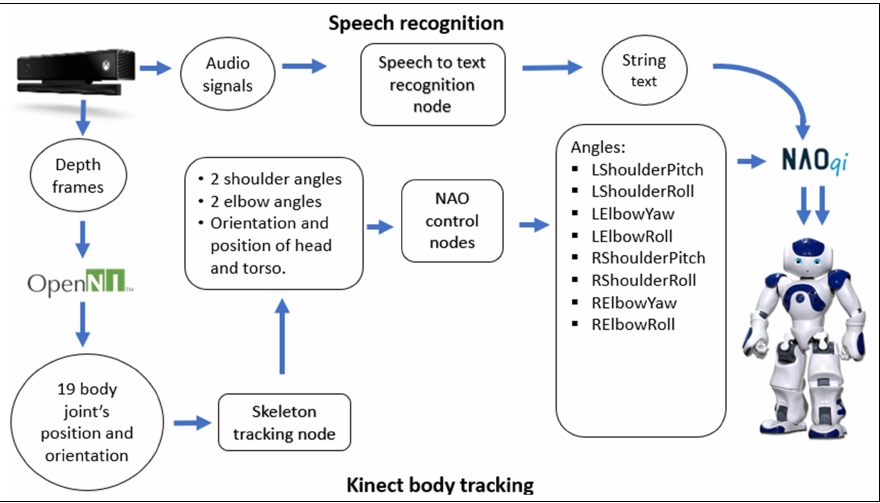
Figure 7. Software architecture of the data acquisition with the Kinect sensor.